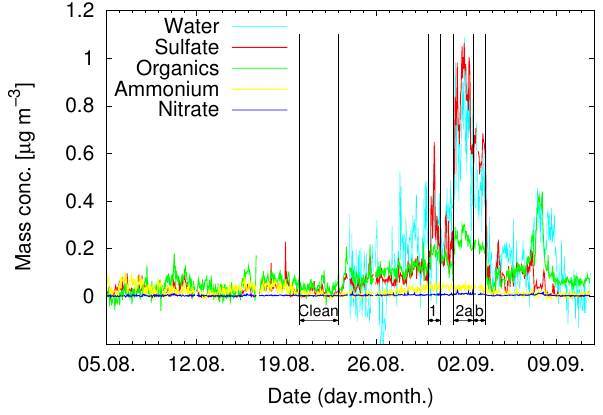
Fig. 3. Time series of AMS mass concentrations of sulfate, total organics, ammonium and nitrate for the aerosol sampled between 13 September 2006, 00:00UTC and 13 October 2006,